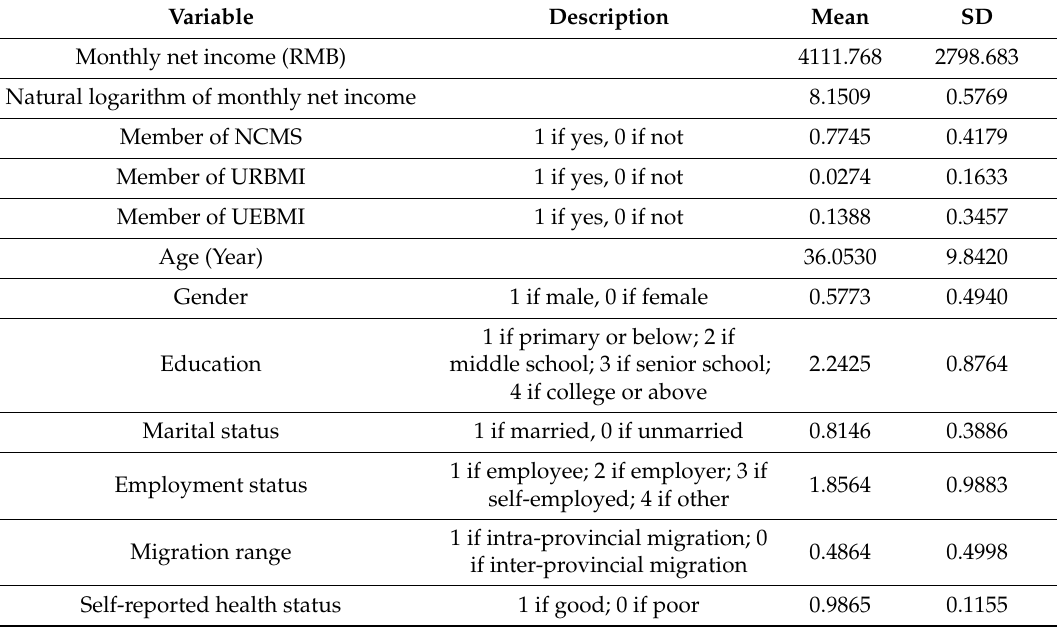
Table 1. Variables, their measurement, and descriptive